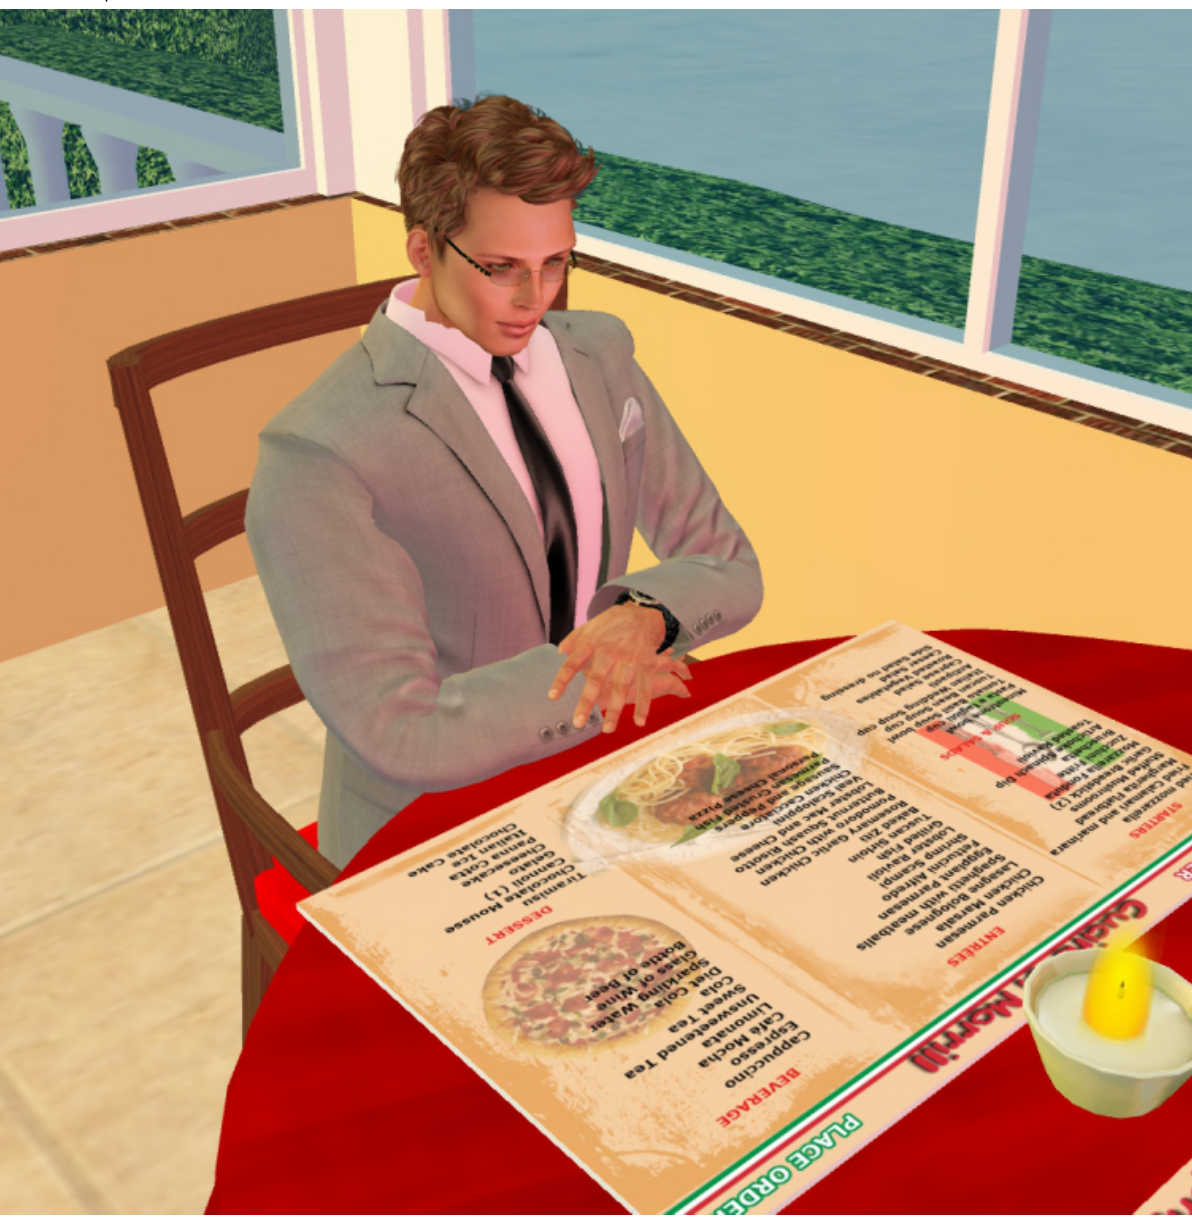
Figure 3. Example of interactive restaurant